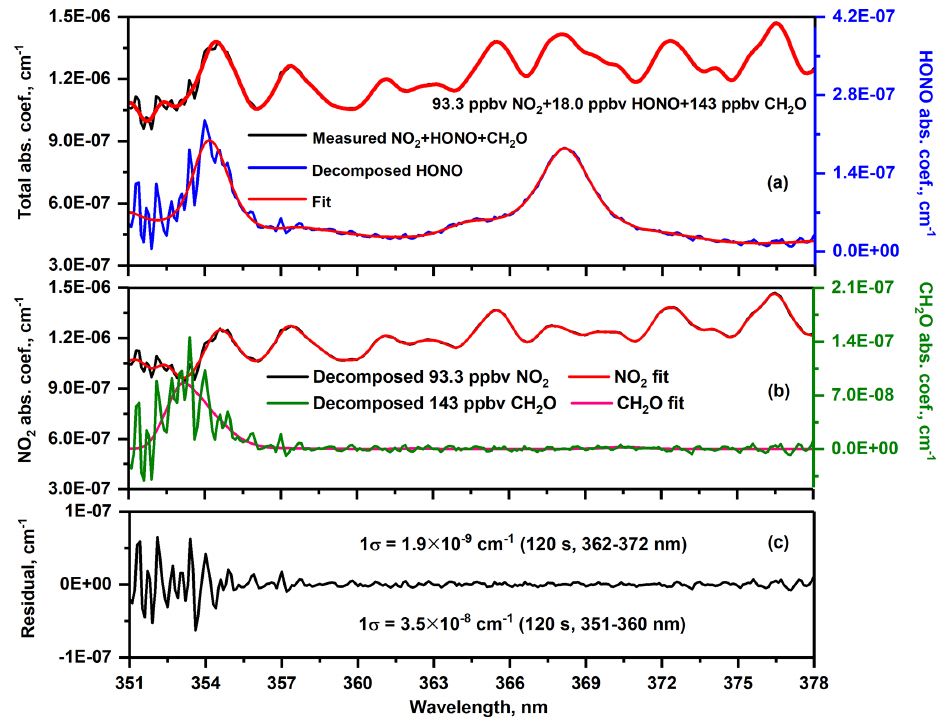
Figure 4. Measured and fitted NO 2 , HONO and CH 2 O spectra associated with the related residual. Decomposed spectra were specified in Kennedy et al. (2011). Table 1. Absorption bands adopted by FTIR for NO 2 , HONO, CH 2 O and H 2 O measurements. IBI: integrated band